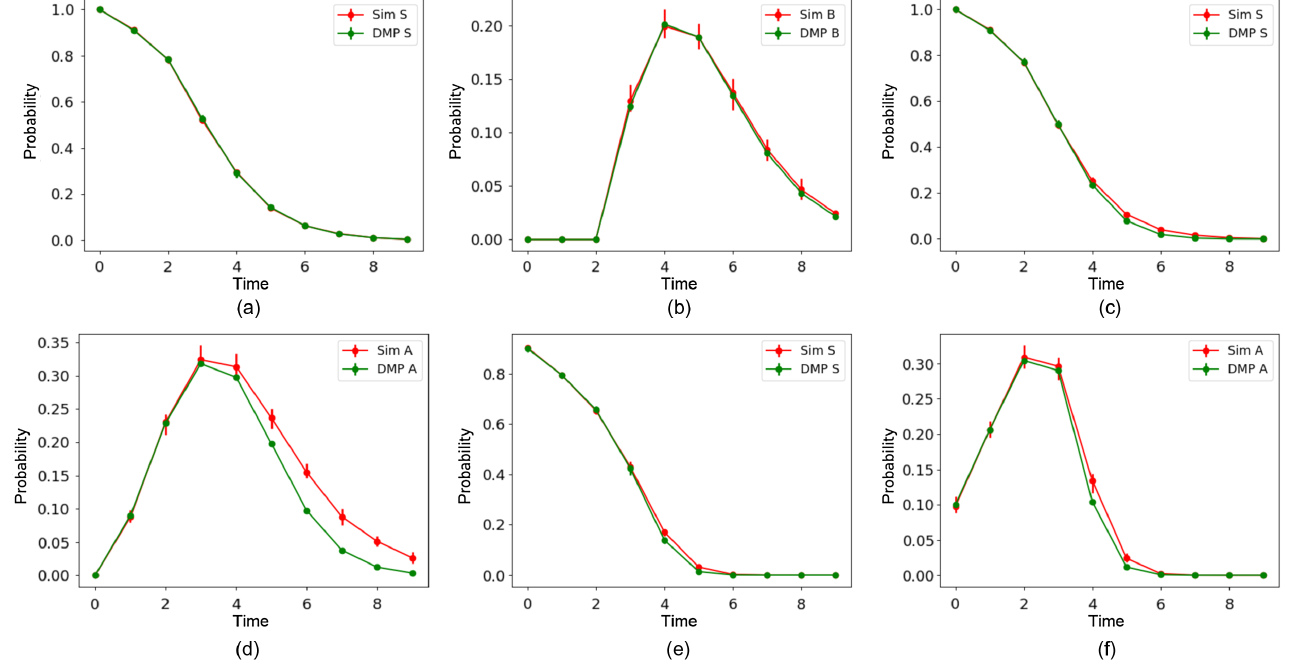
FIG. 3. Comparison of DMP-based results and Monte Carlo simulations for collaborative processes. For each of the graphs, 10 3 samples have been used per node (about 10 5 samples in total), and both mean values and error bars are shown (unless they are smaller than the symbol size). (a) Collaborative process on a treelike network using the parameters α A ¼ 0 . 3 , α B ¼ 0 . 7 , α AB ¼ 0 . 6 , and α 0 . 6 , observing P i ¼ 3 t Þ (the node to monitor has been selected arbitrarily). Process A was seeded at node 7 and process B at node BA ¼ S ð 2. (b) Same as in panel (a) but observing P i ¼ 3 B ð t Þ . (c) Comparing results for the network with loops using the same parameters as in panel (a), observing P i ¼ 3 S ð t Þ and (d) P i ¼ 3 A ð t Þ . (e) Comparing results obtained from the DMP method and Monte Carlo simulations of a collaborative process on the football network. The parameters used are α A ¼ 0 . 1 , α B ¼ 0 . 2 , α AB ¼ 0 . 3 , and α BA ¼ 0 . 4 . The probabilities represent observations of node 2, while process A was seeded at nodes 3 and 4, and process B at nodes 0 and 1 (there is no significance to any of these